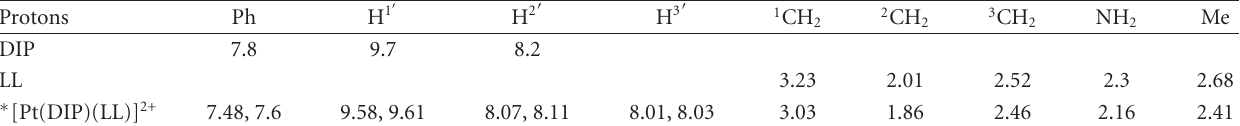
Table 1: 1 H NMR chemical shifts of 4,7-diphenyl-1,10-phenanthroline (DIP) and N,N -dimethyltrimethylenediamine ligand (LL) and [Pt(DIP)(LL)](NO 3 ) 2 complex.